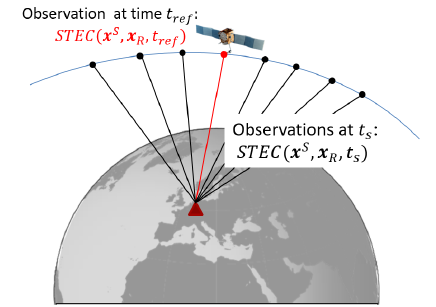
Figure 9. Schematic representation of the dSTEC analysis of one satellite-receiver